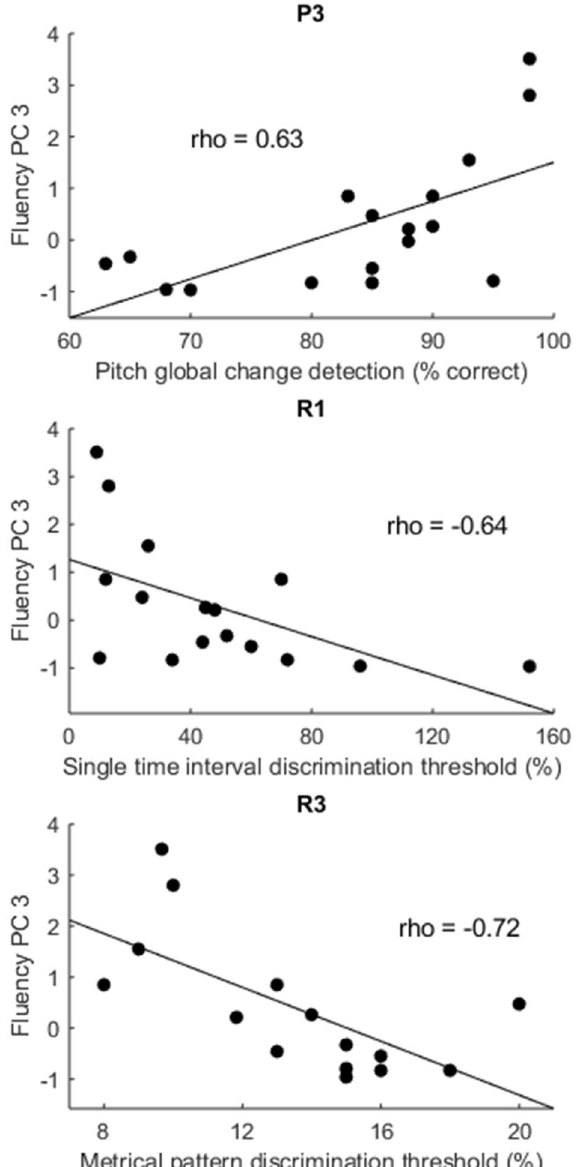
Figure 3. Psychoacoustic measures and speech fluency. Scatter plots showing significant correlations between ‘fluency’ Principal Component 3 scores (y-axis) and P3 (better pitch global change detection associated with better speech fluency), R1 (better single time interval discrimination associated with better speech fluency) and R3 (better metrical pattern discrimination associated with better speech fluency) (on x-axes) in the group of participants with post-stroke aphasia. The straight line represents the least-squares line of best fit. ‘PC’ = Principal Component; ‘P3’ = pitch detection of global change; ‘R1’ = rhythm single time interval discrimination; ‘R3’ = rhythm metrical pattern discrimination for a strongly metrical